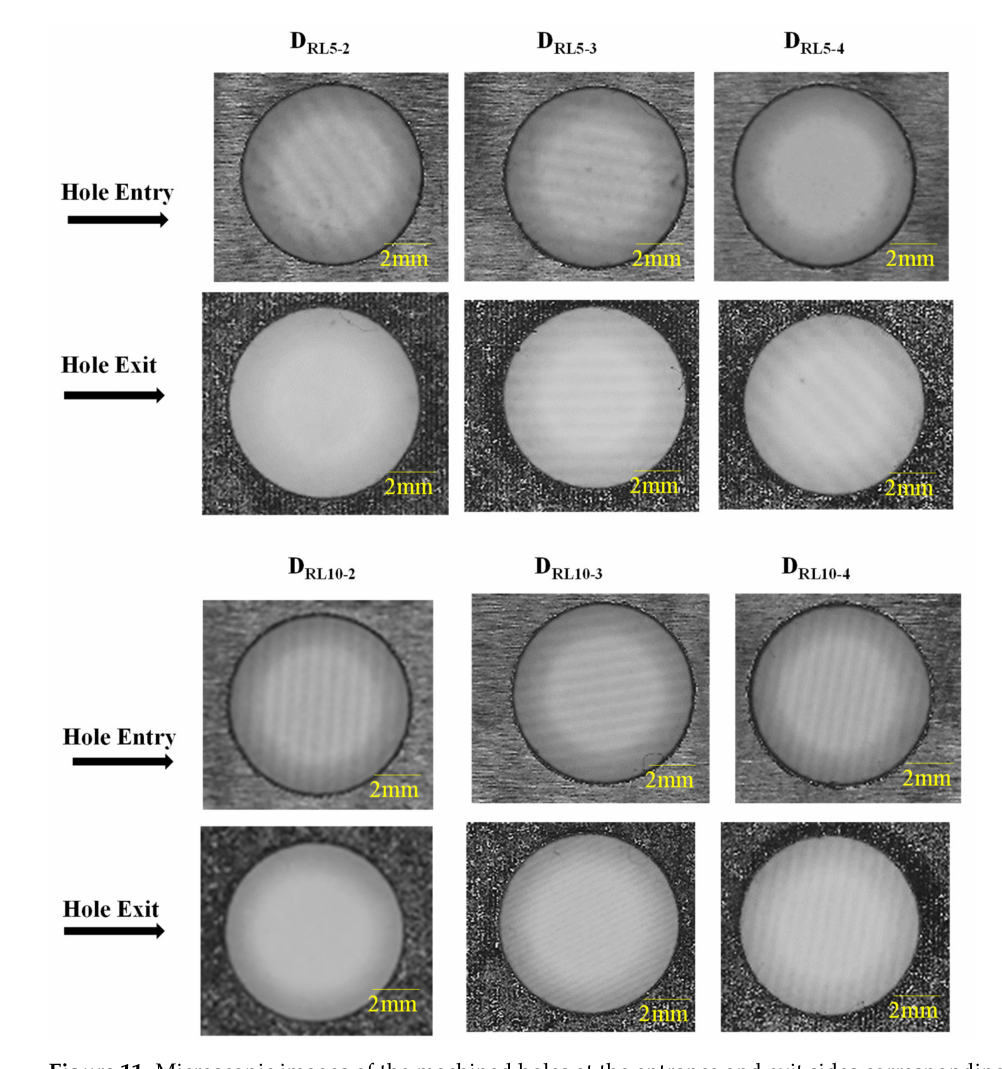
Figure 11. Microscopic images of the machined holes at the entrance and exit sides corresponding to experimentation under varying land lengths of three levels (2, 3, and 4